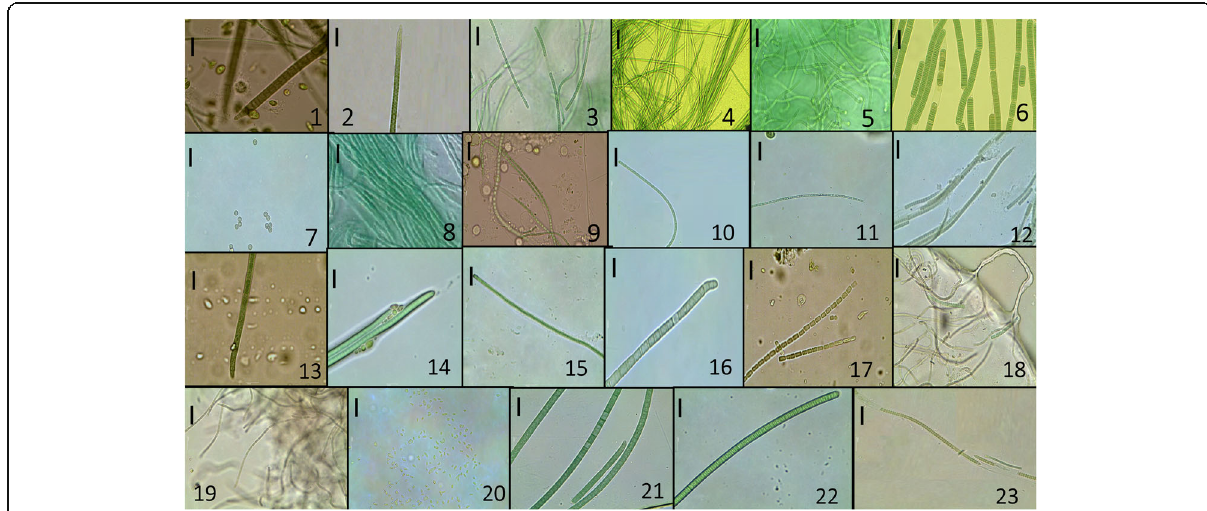
Fig. 4 Microphotographs of identified cyanobacterial strains. 1 Phormidium autumnale , 2 Phormidium crassivaginatum , 3 Pseudanabaena balatonica , 4 Phormidium articulatum , 5 Leptolyngbya faveolarum , 6 Lyngbya sp ., 7 Synechocystis sp , 8 Leptolyngbya sp 1 , 9 Leptolyngbya henningsii , 10 Jaaginema quadripunctulatum , 11 Leptolyngbya benthonica , 12 Pseudophormidium flexuosum , 13, Phormidium attenuattum , 14 Phormidium koprophilum , 15 Phormidium formosum , 16 Phormidium lusitanicum , 17 Pseudanbaena minima , 18 Pseudanabaena galeata , 19 Pseudanabaena mucicola , 20 Synechococcus sp ., 21 Oscillatoria